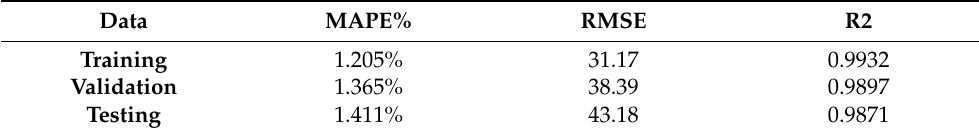
Table 8. Final deep learning model results on training, validation and testing data.